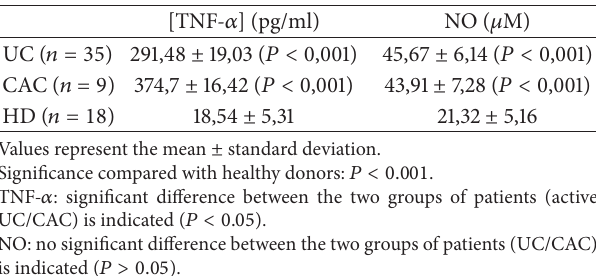
Table 2: Sera TNF- 𝛼 and NO concentrations in patients with ulcerative colitis and colitis associated